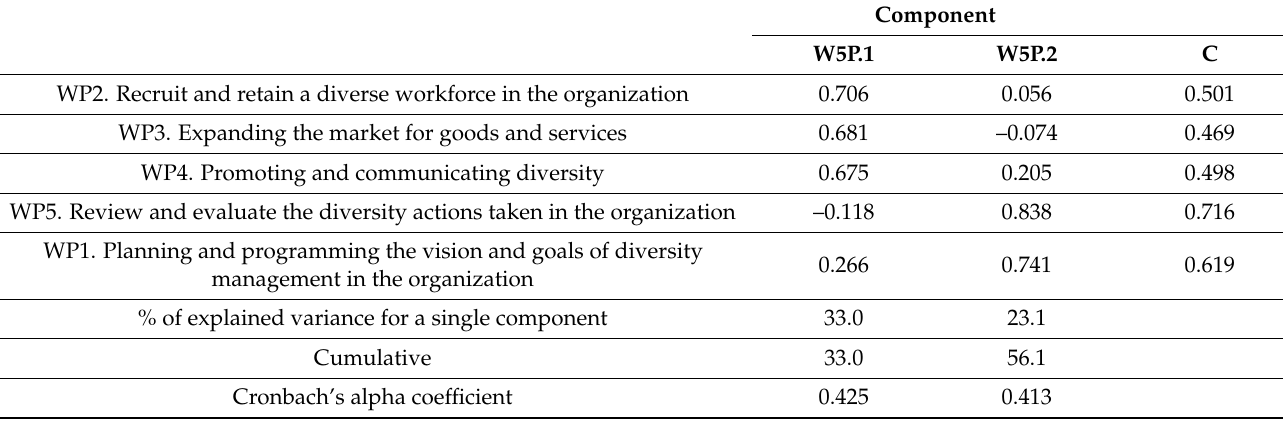
Table 1. Results of exploratory factor analysis for indicator W5P.